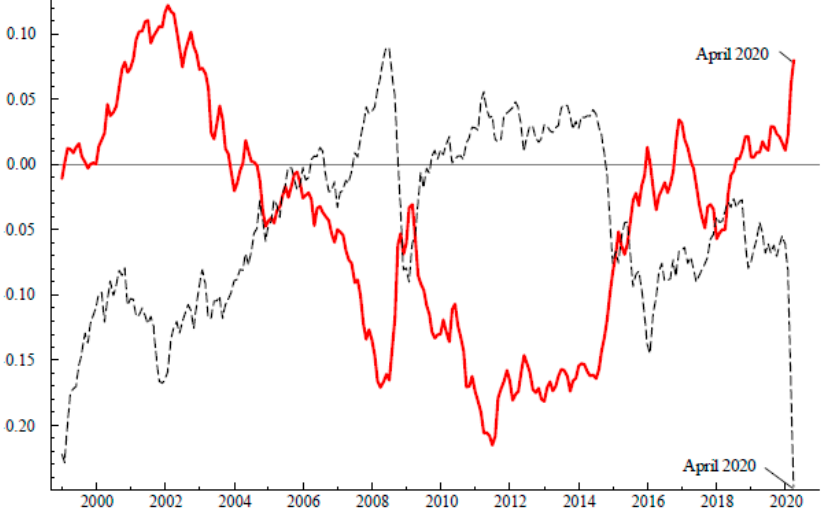
Figure 1. The dashed line is the West Texas Intermediate (WTI) price of oil delineated by the U.S. CPI; the solid line is the Federal Reserve’s broad measure for real effective exchange rate (FX/$). Variables are expressed in logarithms. The mean and range of the series are matched.